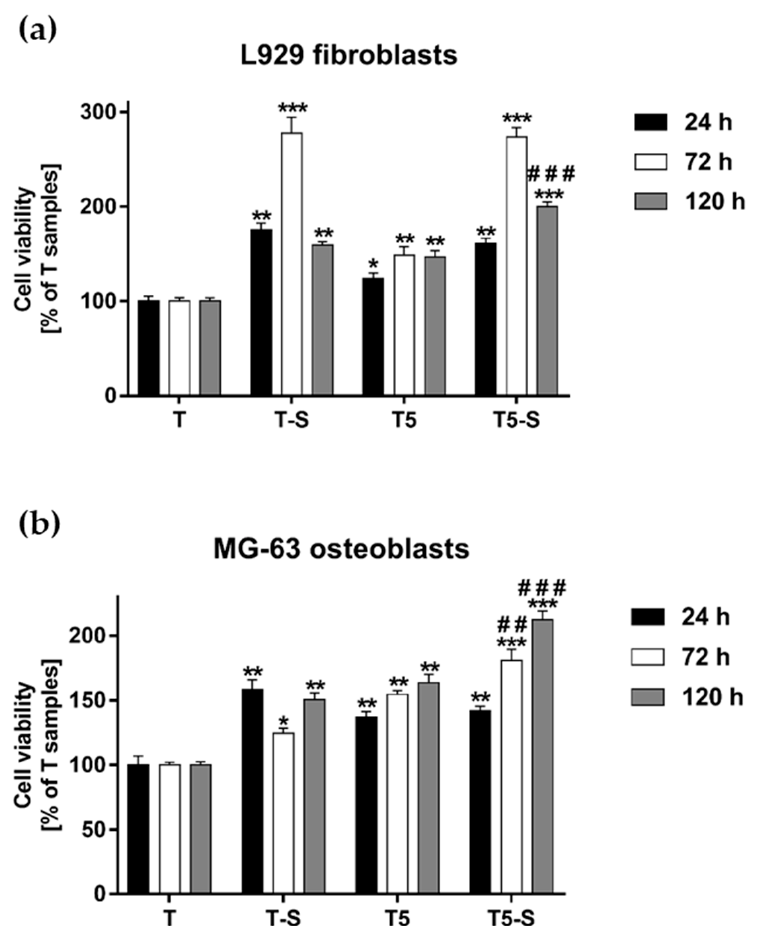
Figure 10. Cell viability of L929 fibroblasts ( a ) and MG-63 osteoblasts ( b ) cultured on the T-S, T5- S, and T5 samples for 24, 72, and 120 h. The results were compared with the reference Ti6Al4V samples (T). The cell viability is presented as a percentage of the control cells growing on the T specimens (served as 100%). Data are presented as the mean ± standard error of the mean (SEM). Asterisks denotes differences when the viability of cells growing on the tested scaffolds was higher compared with T samples (*** p < 0.001, ** p < 0.01, * p < 0.05). The pound signs indicate differences between the cells cultured on the T5-S scaffolds and T-S samples (### p < 0.001, ## p <